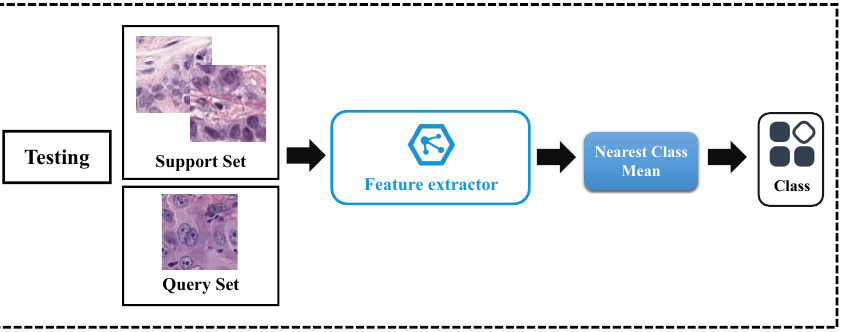
Figure 2. Testing stage of our method. We fix the feature extractor and use the nearest class mean method to classify the image during